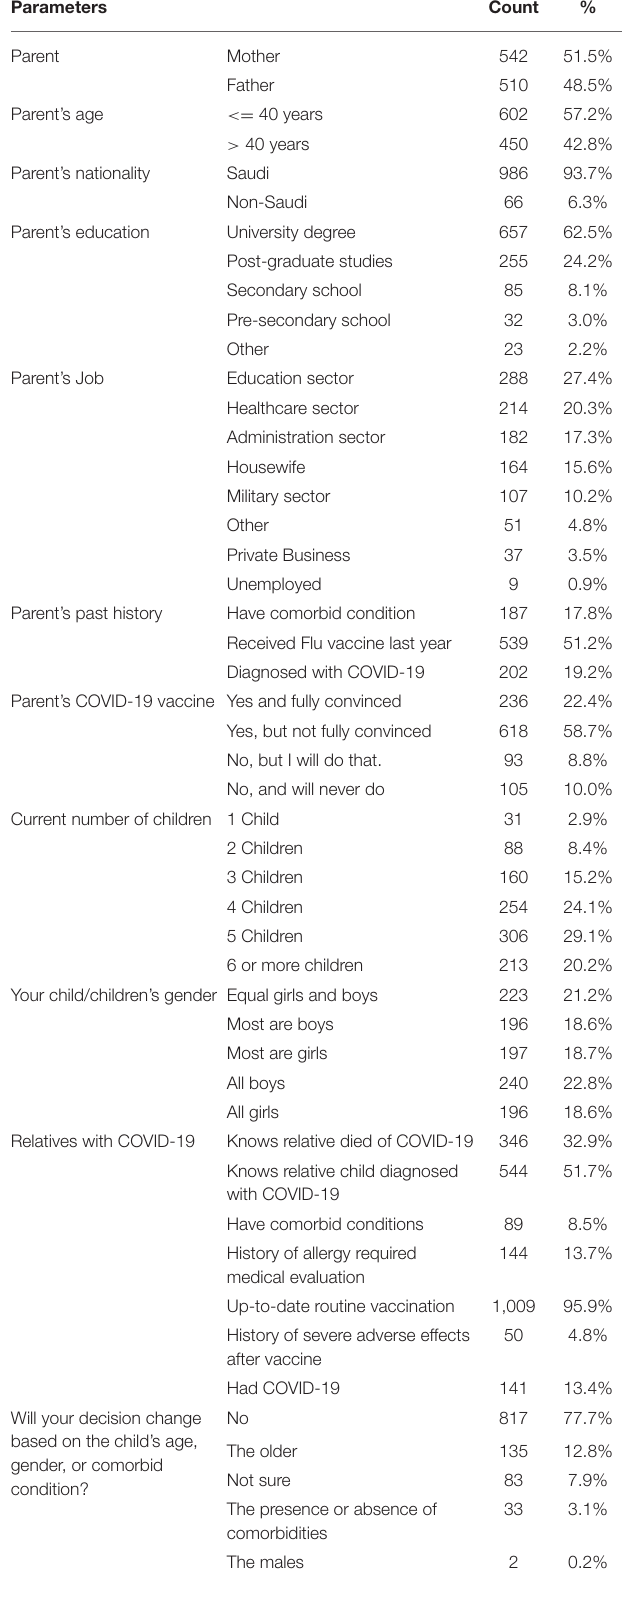
TABLE 1 | Basic characteristics ( n =